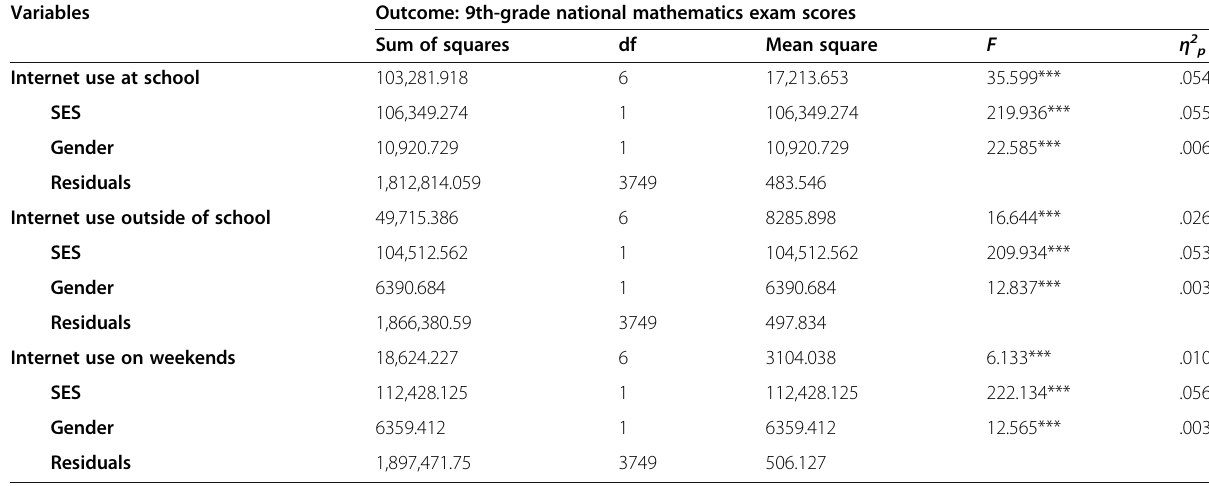
Table 3 Results of ANCOVA analyses for 9th-grade mathematics national exam scores and Internet use variables, controlled for SES and gender Variables